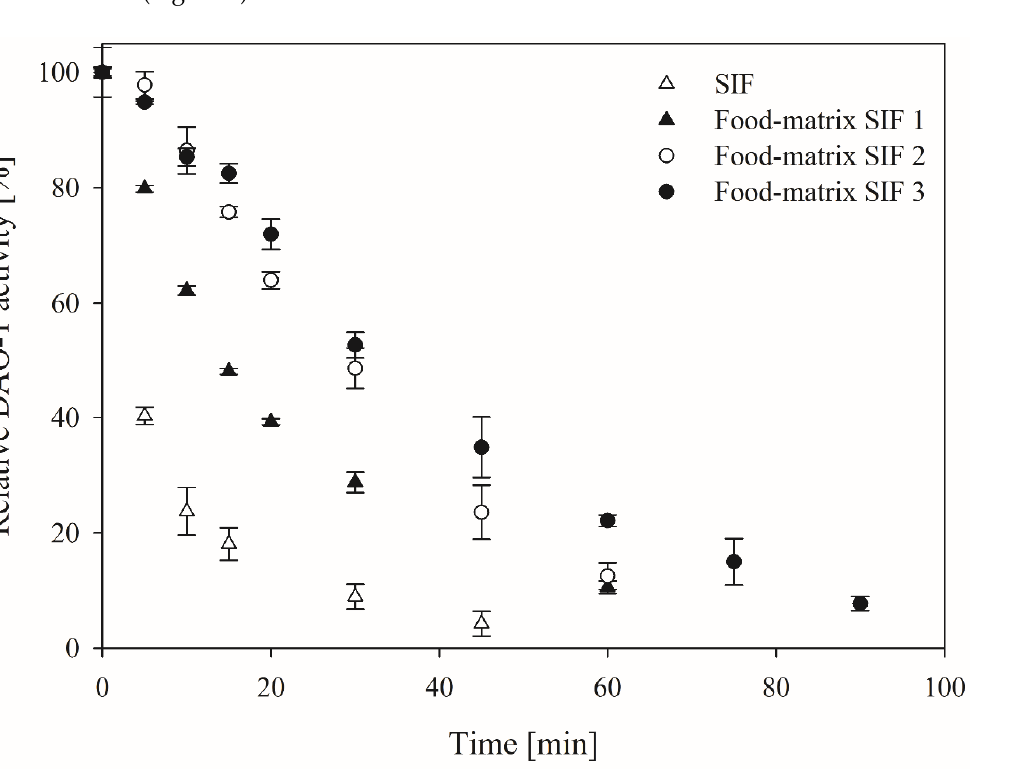
Figure 1. Stability of diamine oxidase (DAO-1) in pure and modified simulated intestinal fluid (SIF). Food matrix SIF 1 contained 50 g bovine serum albumin (BSA)·L − 1 and 25 g sucrose·L − 1 . Food matrix SIF 2 contained BSA and whey protein isolate (WPI), each at 25 g·L − 1 and 50 g sucrose·L − 1 . Food matrix SIF 3 contained BSA, WPI, and sodium caseinate, each at 16.67 g·L − 1 and 50 g sucrose·L − 1 . A total of 100% DAO-1 activity = 1.25 ± 0.15 nkat Histamine ·mL − 1 . DAO-1 showed poor stability in pure SIF with a half-life period of less than 5 min. The addition of 50 g BSA·L − 1 and 25 g sucrose·L − 1 (food matrix SIF 1) improved the half-life period of DAO-1 to around 15 min.